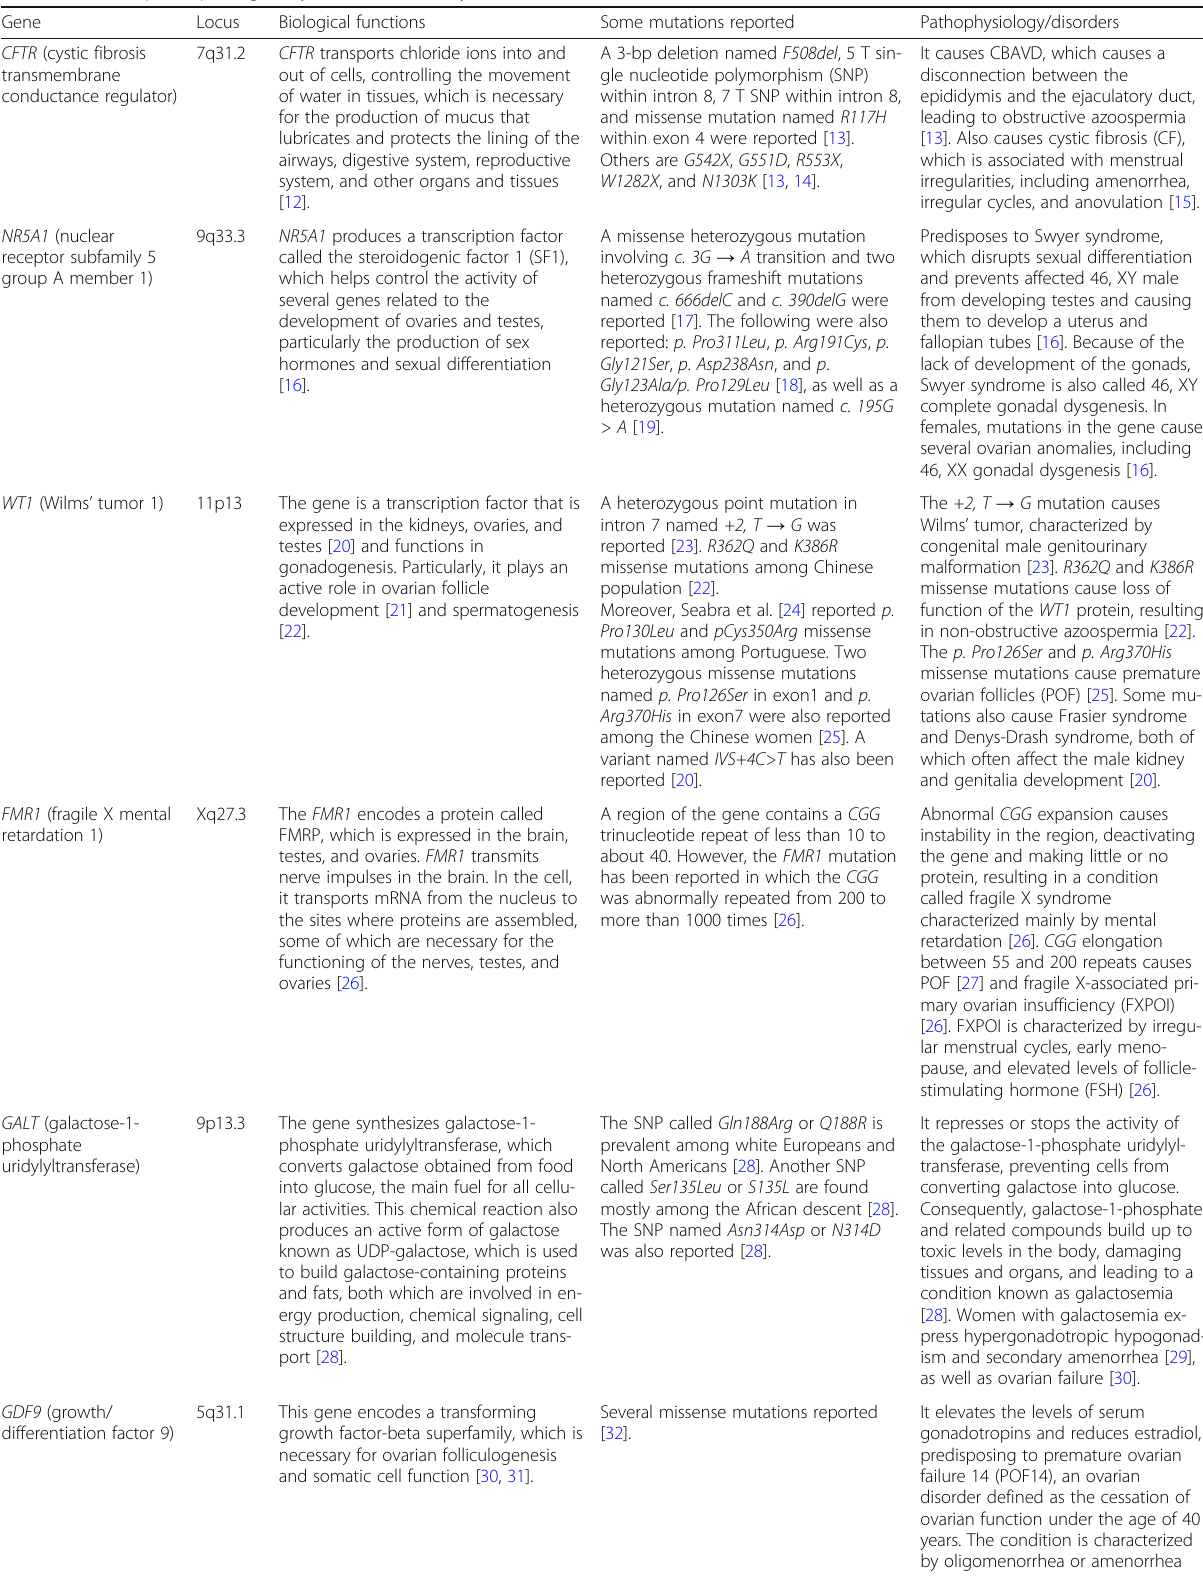
Table 1 Genes predisposing to syndromic